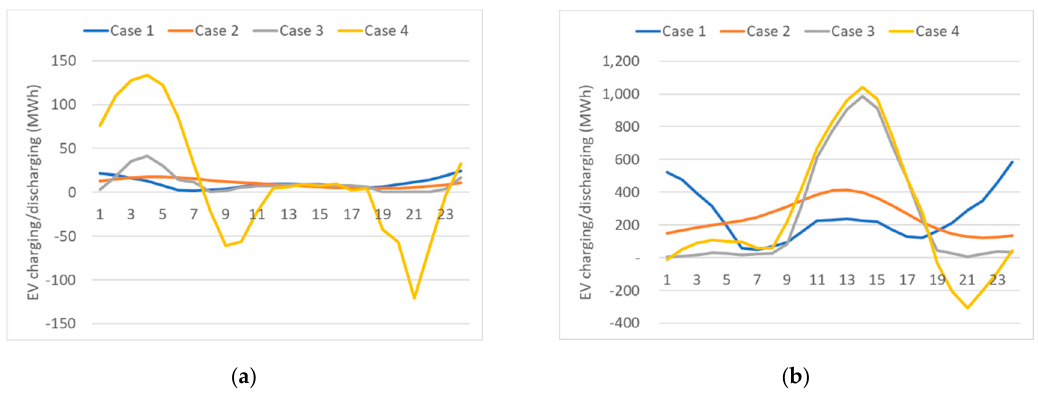
Figure 12. Optimal charging/discharging profiles of DR programs in 2019 and 2030: ( a ) 2019; ( b ) 2030.